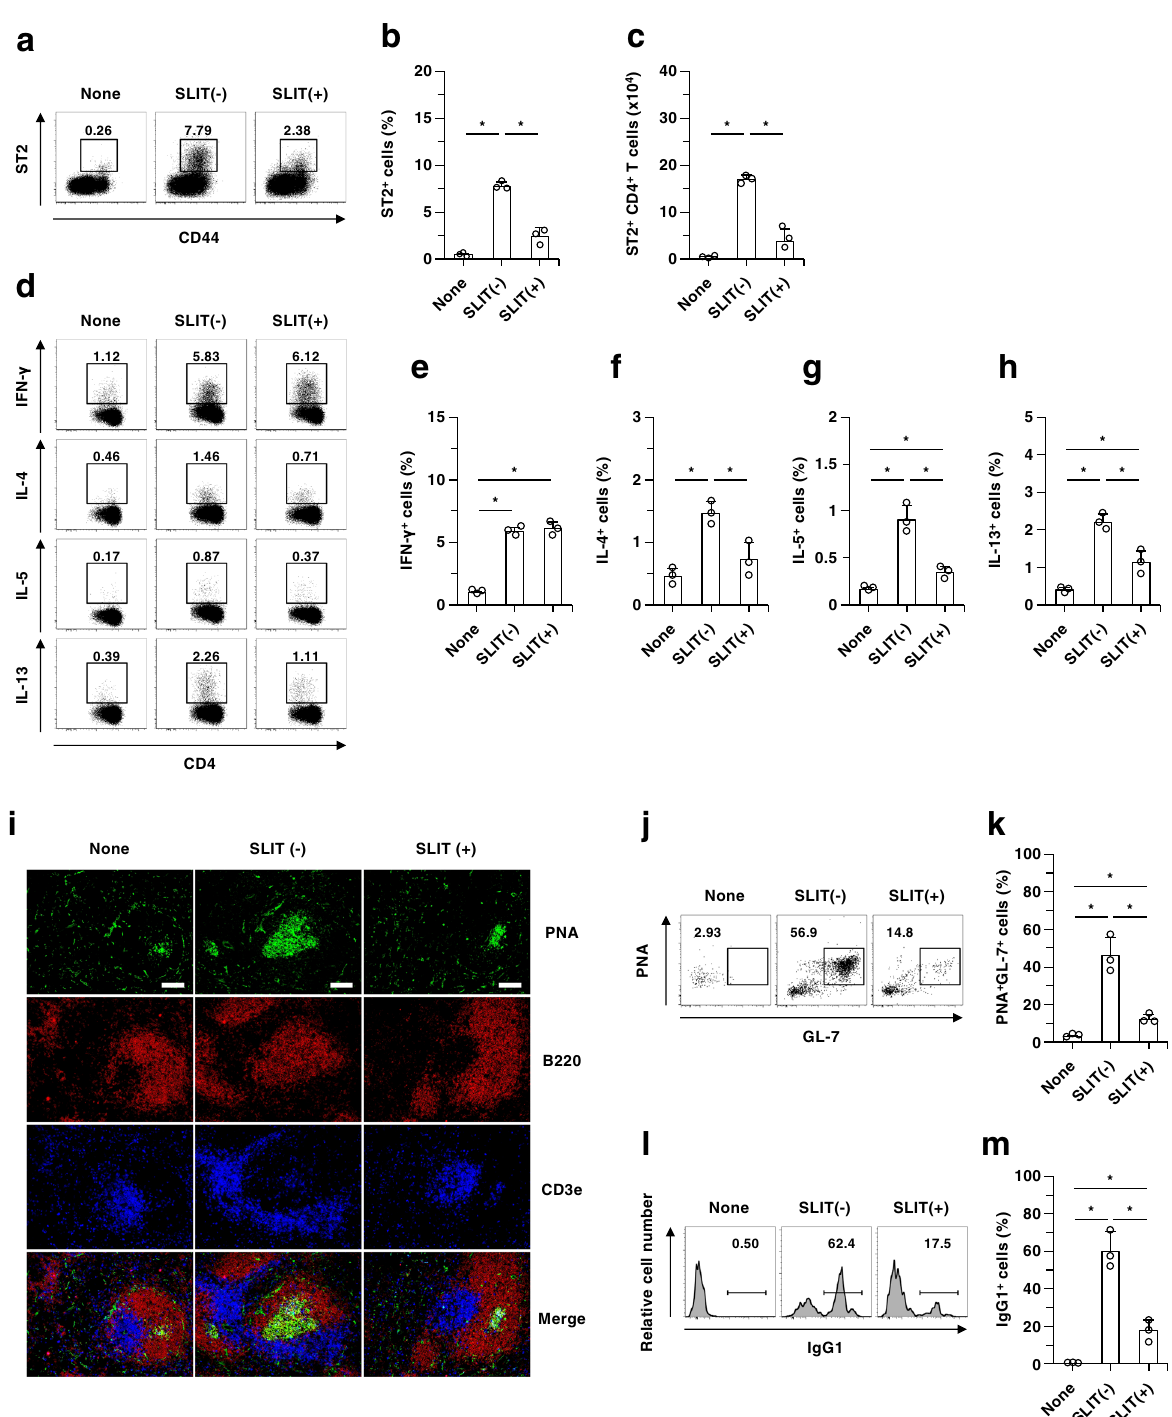
Fig. 2 SLIT prevents T H 2-mediated allergic immune responses in lung of asthmatic mice. WT mice were immunized as described in Fig. 1 for the induction of allergic airway in fl ammation. a – c Cell surface expression pro fi le a and proportion b of ST2 + CD44 + cells among CD4 + T cells, and absolute cell number c of CD4 + ST2 + CD44 + T cells in lung. d – h Intracellular cytokine expression pro fi le d and proportion e – h of lung CD4 + T cells. i Frozen sections obtained from spleen were stained for PNA (green), B220 (red), and CD3 ε (blue) at low-magni fi cation (×20). Bars indicate 100 μ m. j – m Cell surface expression pro fi le j , l and proportion k , m of PNA + GL7 + j , k , and IgG 1 + l , m cells within OVA-speci fi c B cells in the spleen. Data are obtained from fi ve individual samples in a single experiment. * P < 0.05 compared with normal mice (none) or among groups. All data are representative of at least 3 independent